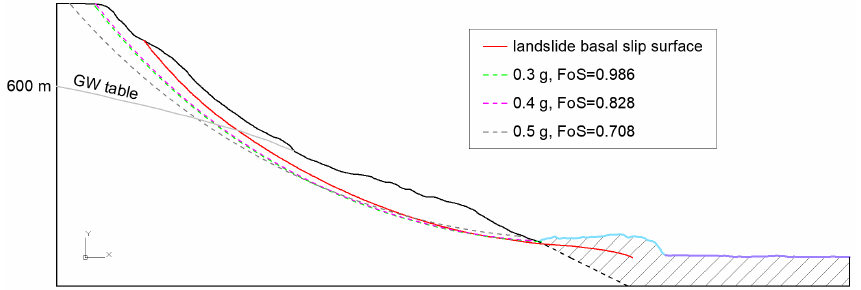
Figure 11. Sliding surfaces obtained under different seismic acceleration conditions for Set